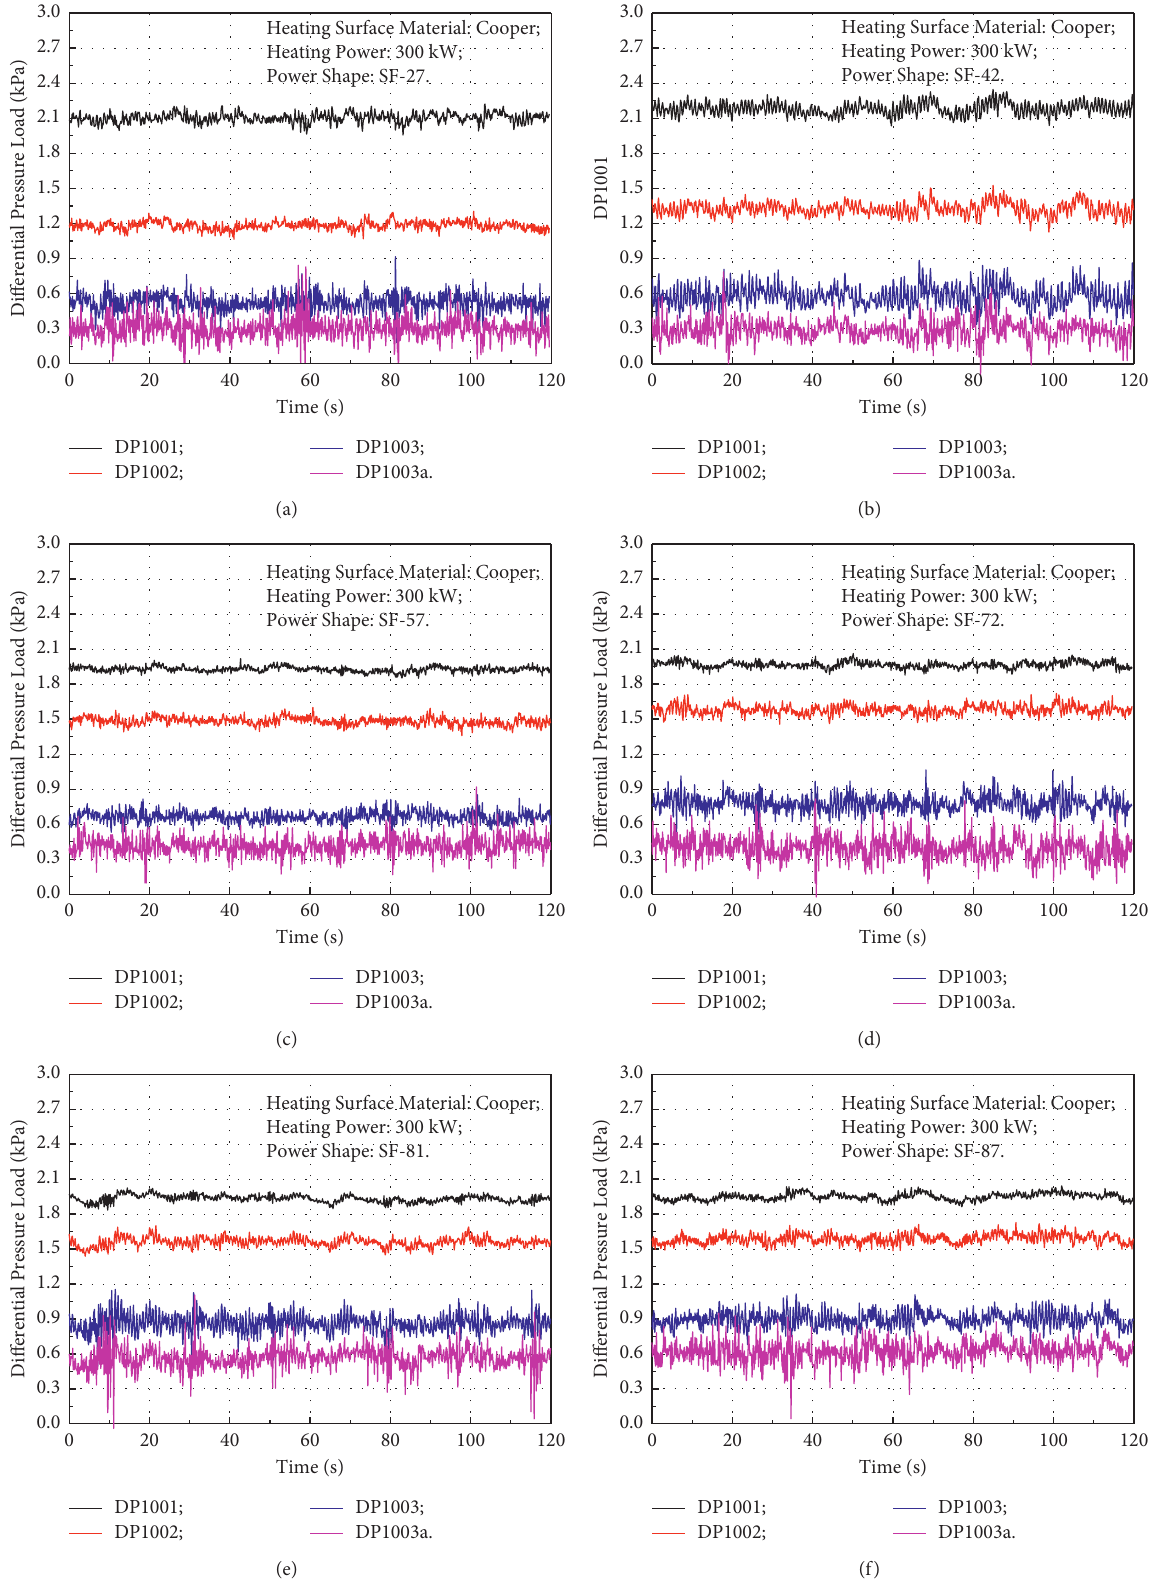
Figure 10: Pressure drops when P � 300 kW . (a) SF-27. (b) SF-42. (c) SF-57. (d) SF-72. (e) SF-81. (f) total